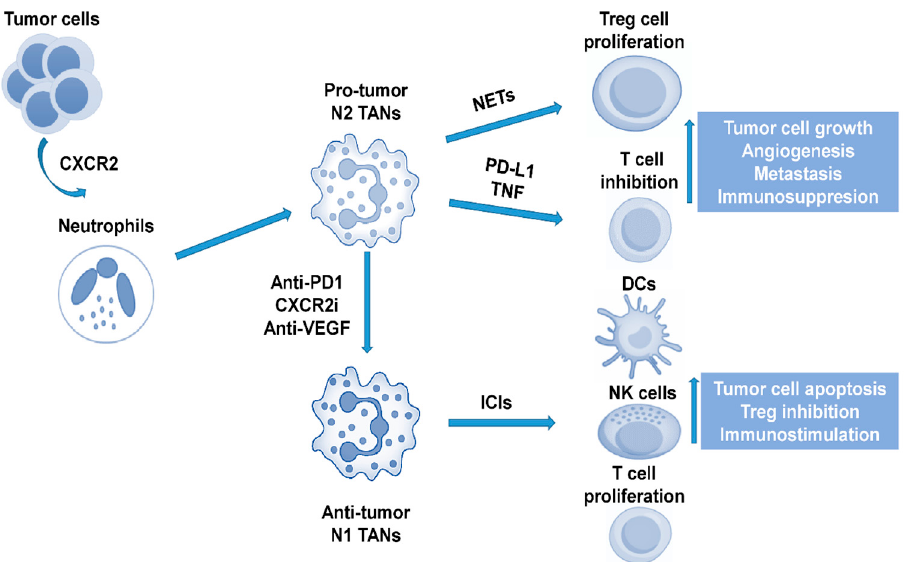
Figure 1. The role of neutrophils in the liver cancer immune microenvironment. CXCR2: C-X-C motif chemokine receptor 2; TAN: tumor-associated neutrophil; PD1: programmed cell death protein 1; CXCR2i: C-X-C motif chemokine receptor 2 inhibitor; NET: neutrophil extracellular trap; PD-L1: programmed death-ligand 1; ICI: immune checkpoint inhibitor; Treg: regulatory T; DC: dentritic cell; NK: natural killer.